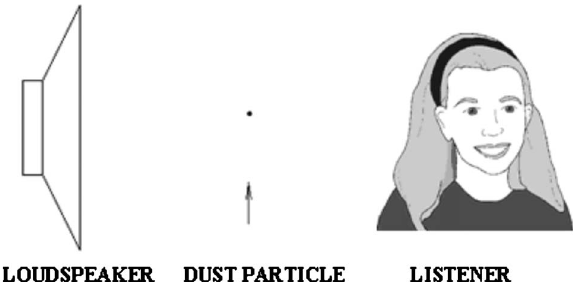
FIG. 6. Picture available to students for better understanding of the situation and for optional drawing during discussion related to contexts 3 and 3a in